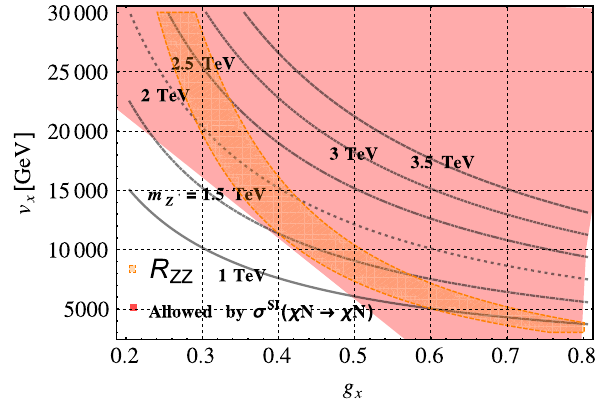
Fig. 3 The inclined and curved dark area (orange online) represents theconsistentregionwith R ZZ ∗ whilethelargearea(lightred)indicates the allowed values by the upper limit on σ SI (χ N → χ N ) . The white area represents the excluded region by both observables. Curved lines represent the predicted value of m Z (cid:2) as a function of υ x and g